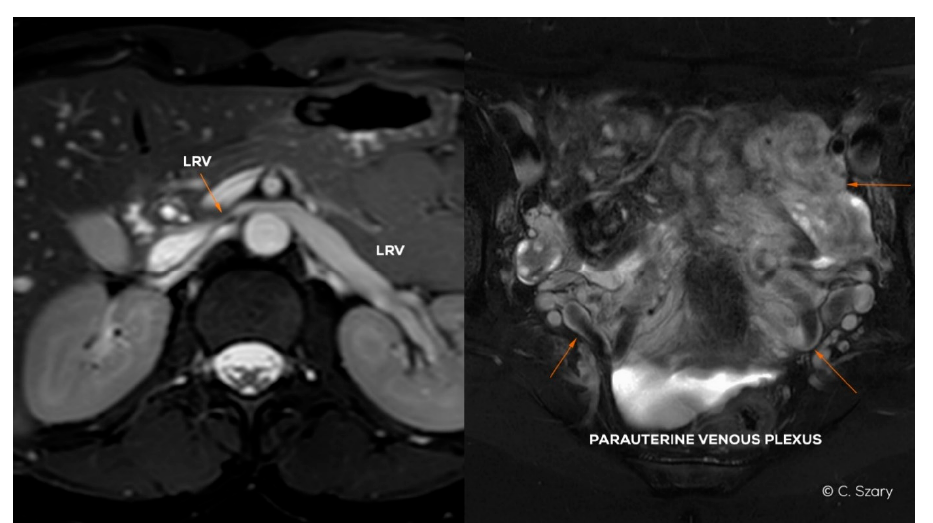
Figure 4. Magnetic resonance (MR) images (BTFE and T2-weighted sequences in axial plane) presenting LRV partial hypoplasia and secondary para-uterine varices caused by LOV insufficiency.